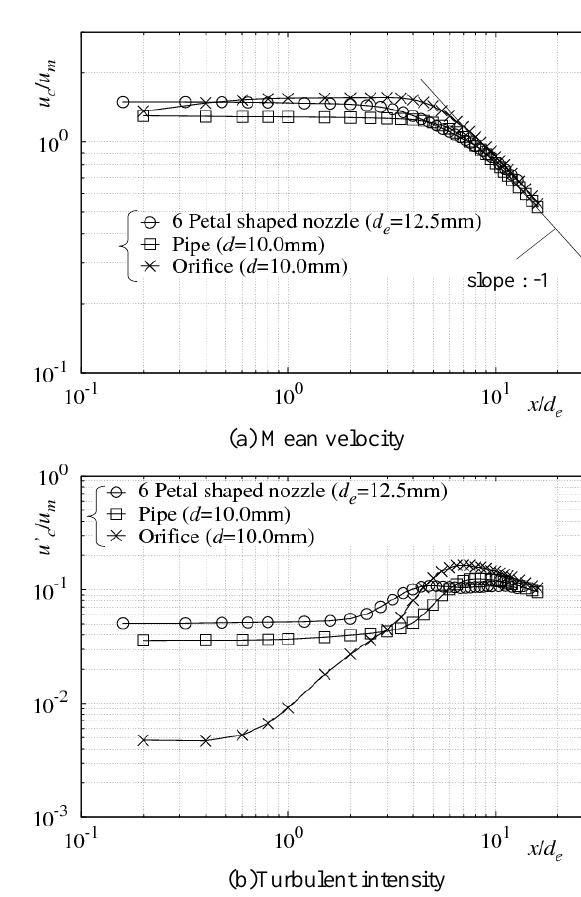
Fig.9 Mean and fluctuating velocities on jet centerline